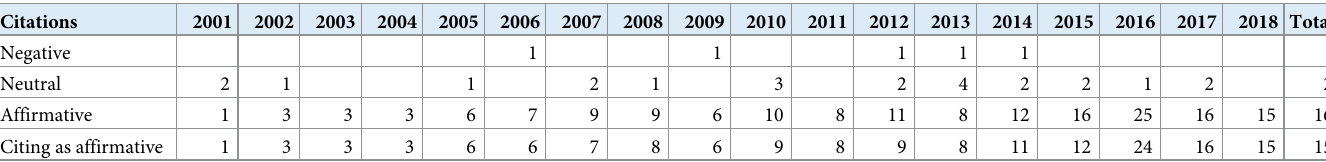
Table 3. Reception of Wickstro¨m and Bendix